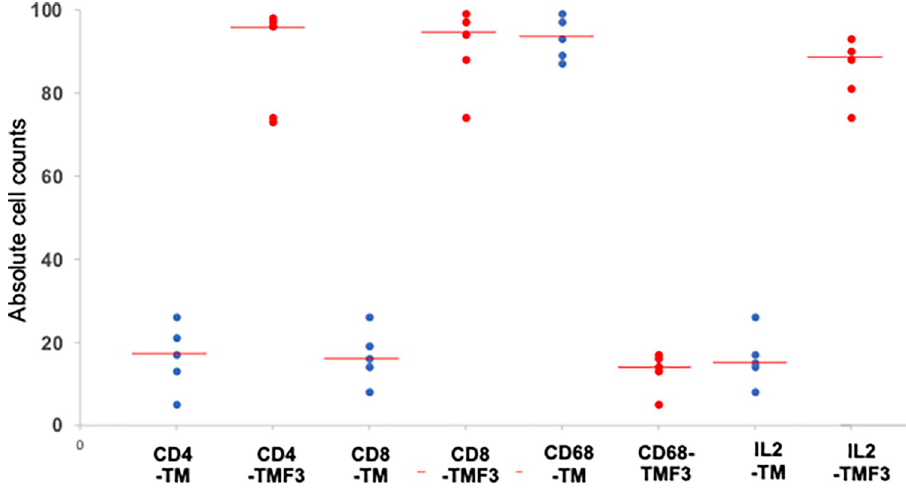
Fig 5. Absolute counts for expression of CD4, CD8, CD68 and IL-2 molecules in treated and untreated tumors. P values were calculated using Mann-Whitney test for comparison of absolute cell counts between untreated (TM) and treated (TM-F3) tumor-bearing